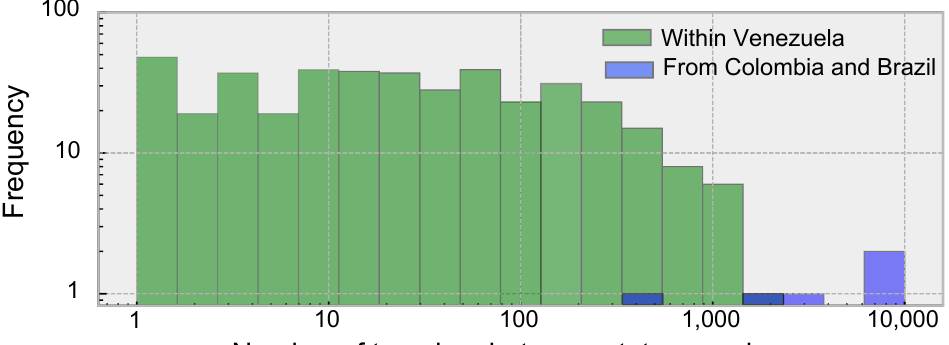
Figure 3. Frequency of daily movements between states used in the simulations with the SEI metapopulation model, derived from the Gravity function and calibrated against observed dynamics. The volume of daily movements within Venezuela was orders of magnitude smaller than from Colombia and